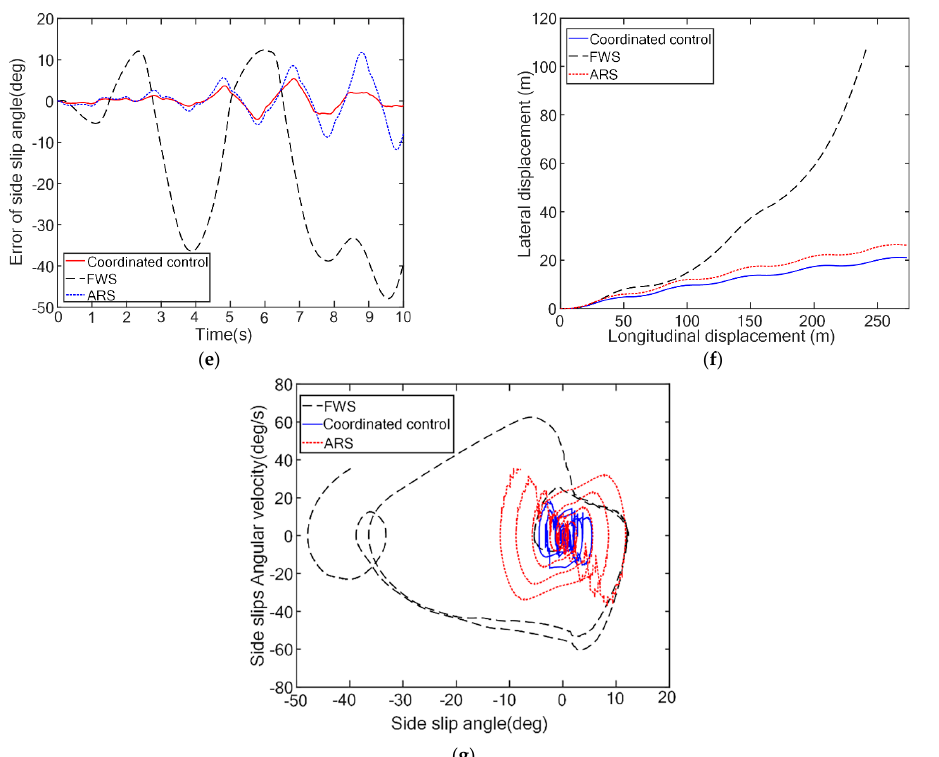
Figure 16. Hardware-in-the-loop test results under continuous sine gain conditions. ( a ) The curve of wheel steering angle change. ( b ) Wheel torque under coordinated control. ( c ) Variation curve of vehicle speed. ( d ) Response curve of the yaw rate. ( e ) Error response curve of the side slip angle. ( f ) Displacement of the center of mass of the vehicle. ( g ) Phase plane diagram of the side slip angle.